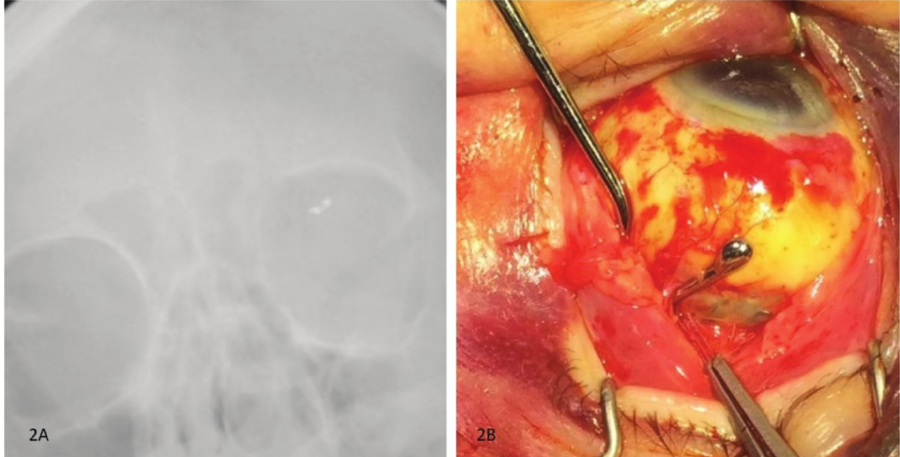
Figure 2. (A) Intraoperative X-ray demonstrating metallic foreign body in left orbit to be symmetric surgical clip. (B) Metallic surgical clip used to secure buckle located